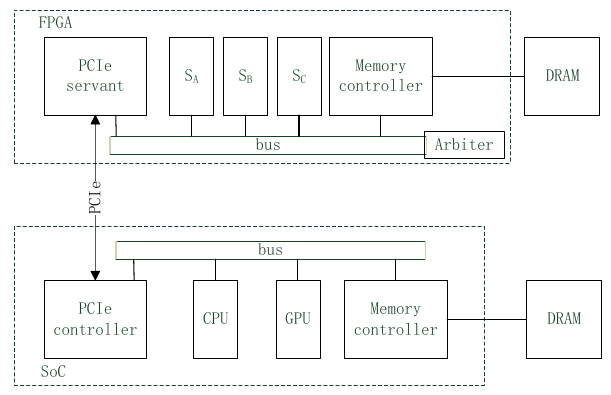
Figure 7. Bus-style communication architecture.